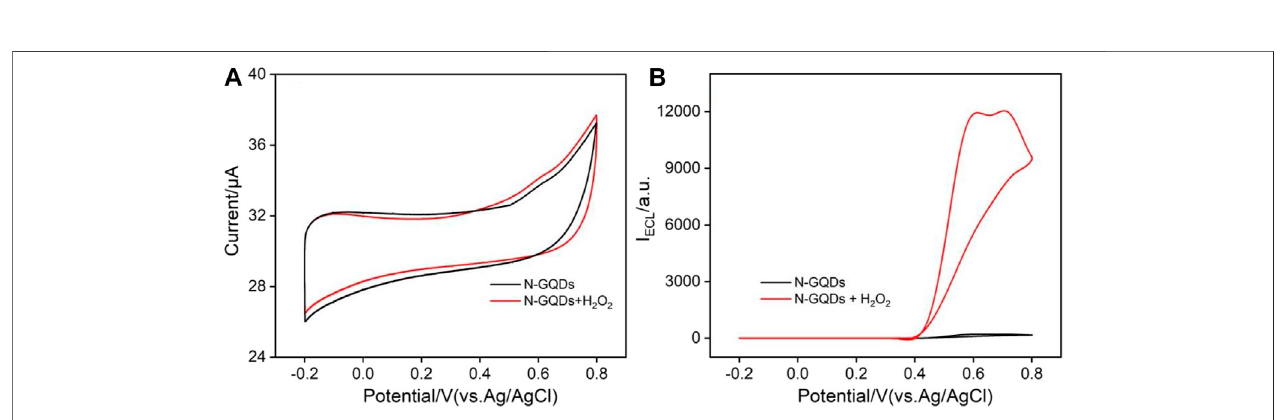
FIGURE3| Cyclicvoltammograms (A) andECLintensity – potentialcurves (B) ofN-GQDs(50 μ g/ml)intheabsenceorpresenceofH 2 O 2 inPBS(0.1 M,pH (cid:2) 10.0).